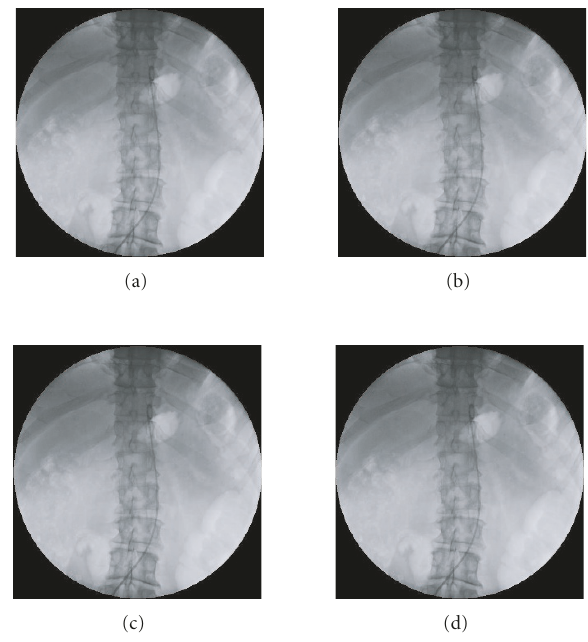
Figure 10: Medical image “Kidney”: (a) the original image; (b) 6.53 times DCT compressed image; (c) 6.67 times compressed image with Algorithm 2; (d) 6.72 times compressed image with Algorithm 3.